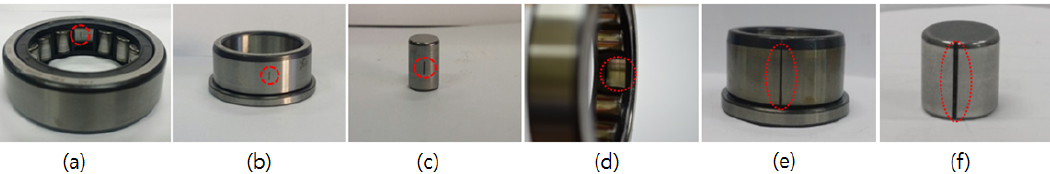
Figure 3. ( a ) Bearing fault signal collection test rig and ( b ) data acquisition system.